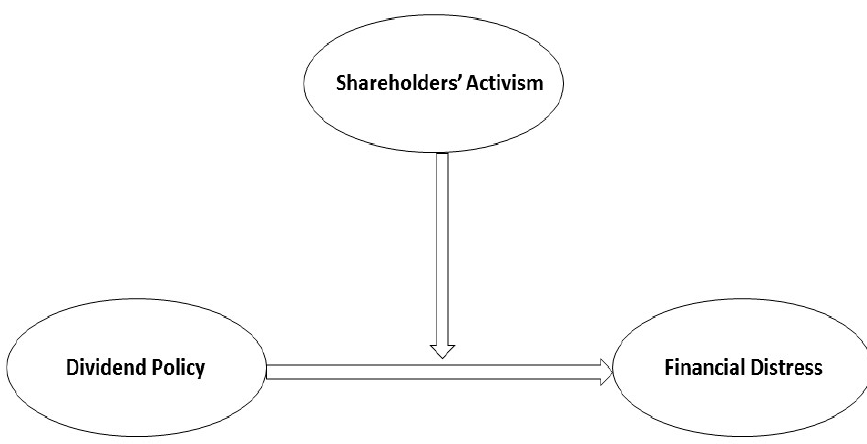
Figure 1. Conceptual Model. Source: Author’s own analysis. Hypothesis 2 (H 2 ). Shareholder activism significantly moderates the association between financial distress (FD) and dividend payout policy of Indian